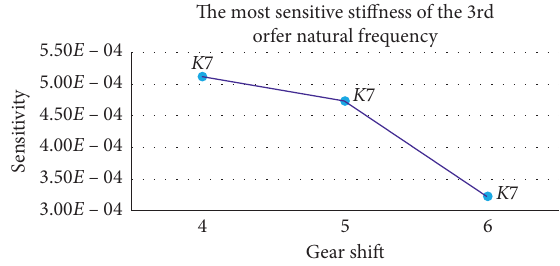
Figure 12: The sensitivities of natural frequency to K